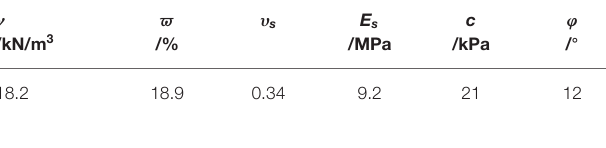
TABLE 2 | The physical calculation parameters of anchor structure.